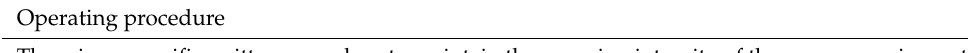
Table 6. Overall process (whole plant)—collection of useful information for BioHazOp